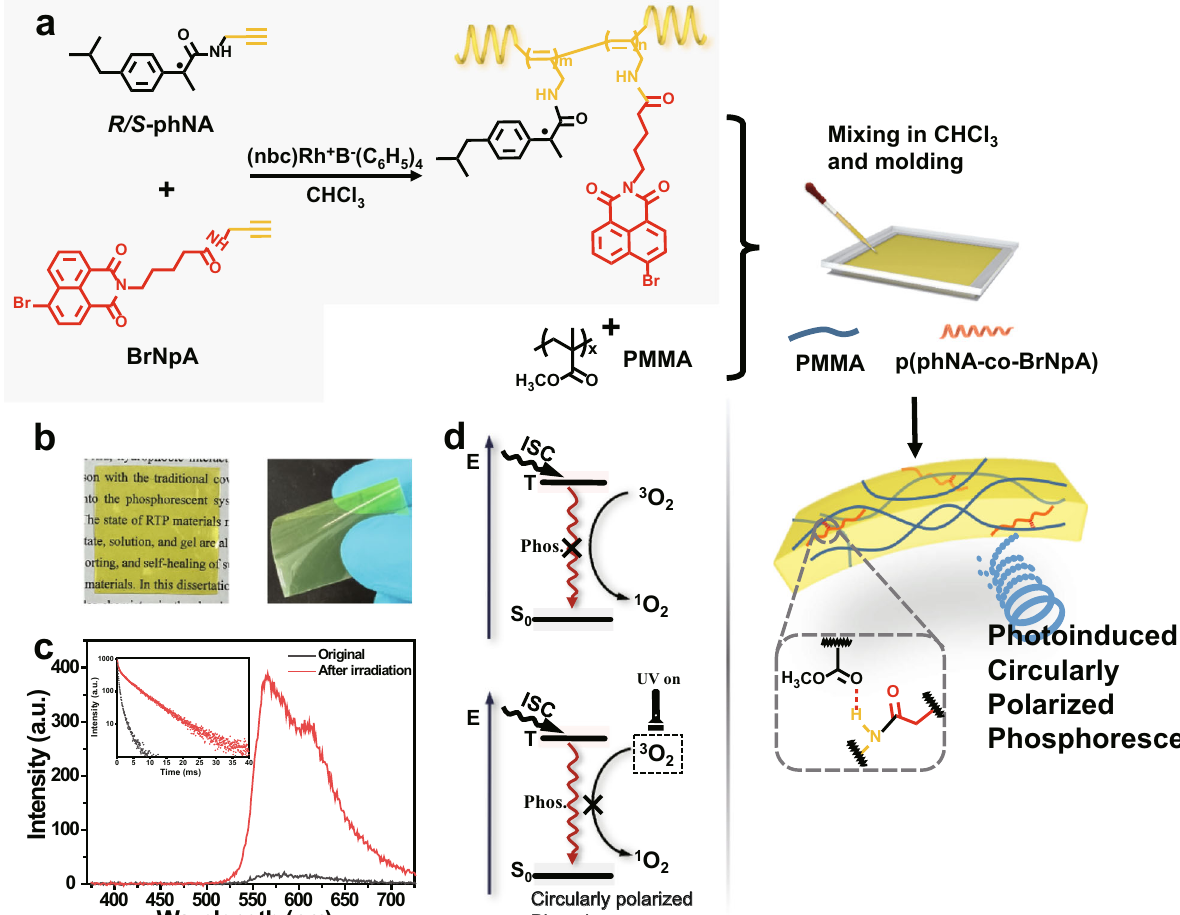
fl exible and could be bent. c Gated emission spectra of p(phNA Insetshows the phosphorescencedecaycurves ( λ ex =365nm, delaytime=0.1ms). d Energy diagram and performance characterization of oxygen consump- tion in fi